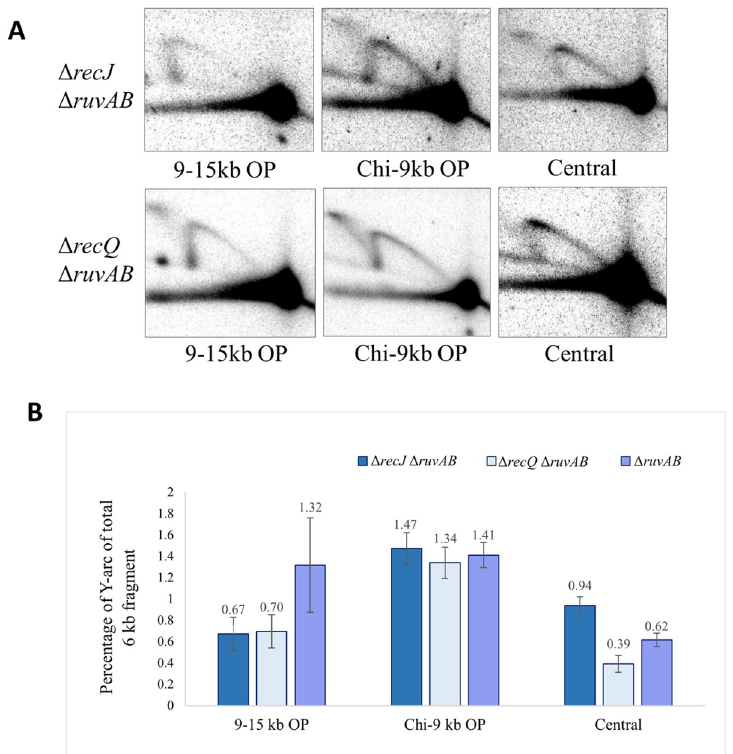
Fig 8. Distribution of repair forks across the central, Chi-9kb and 9-15kb fragments on the origin-proximal side of the DSB isolated from Δ ruvAB single mutant, Δ recJ Δ ruvAB and Δ recQ Δ ruvAB double mutant strains grown in presence of arabinose. A) 2-D gels of the non-crosslinked 9-15kb OP, Chi-9kb OP and central fragments for Δ recJ Δ ruvAB and Δ recQ Δ ruvAB strains containing the palindrome, grown in the presence of 0.2% arabinose for 60 minutes. B) Quantification of repair forks generated in the non-crosslinked DNA samples represented as percentage of DNA in the Y-arc out of the total 6kb DNA fragments. OP and OD mean origin-proximal and origin-distal sides. Error bars represent the standard error of the mean where n = 3. The strains used were DL7859 ( Δ recJ Δ ruvAB , 9-15kb OP), DL7857 ( Δ recJ Δ ruvAB , Chi-9kb OP), DL7827 ( Δ recJ Δ ruvAB , Chi-Chi), DL7591 ( Δ recQ Δ ruvAB , 9-15kb OP), DL7874 ( Δ recQ Δ ruvAB , Chi-9kb OP), DL7588 ( Δ recQ Δ ruvAB , Chi-Chi), DL7259 ( Δ ruvAB , 9-15kb OP), DL7253 ( Δ ruvAB , Chi-9kb OP) and DL7272 ( Δ ruvAB ,